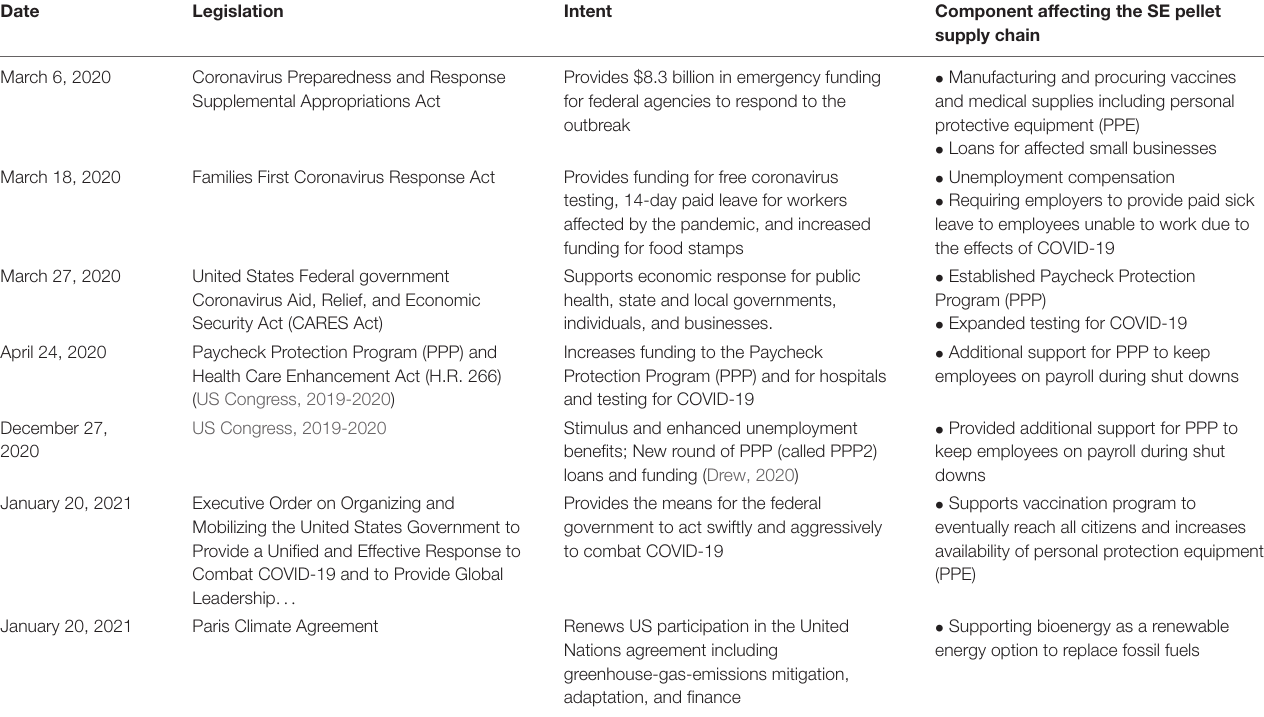
TABLE 1 | Examples of legislation and executive orders related to the pandemic in the United States and their relationship to the SE pellet supply